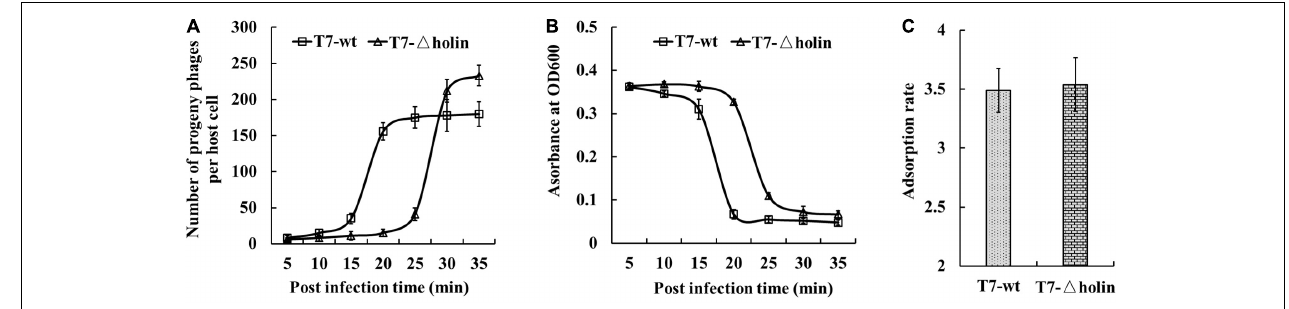
FIGURE 3 | Phenotypic characterization of T7- (cid:52) holin deletion phage. (A) One-step growth curve for burst size measurement of the T7-wt (squares) and T7- (cid:52) holin (triangles) phages. (B) Lysis curves for estimation of onset of lysis for T7-wt and T7- (cid:52) holin phage infections. (C) Adsorption rates measured for the T7-wt and T7- (cid:52) holin phages. Vertical error bars represent standard deviations.